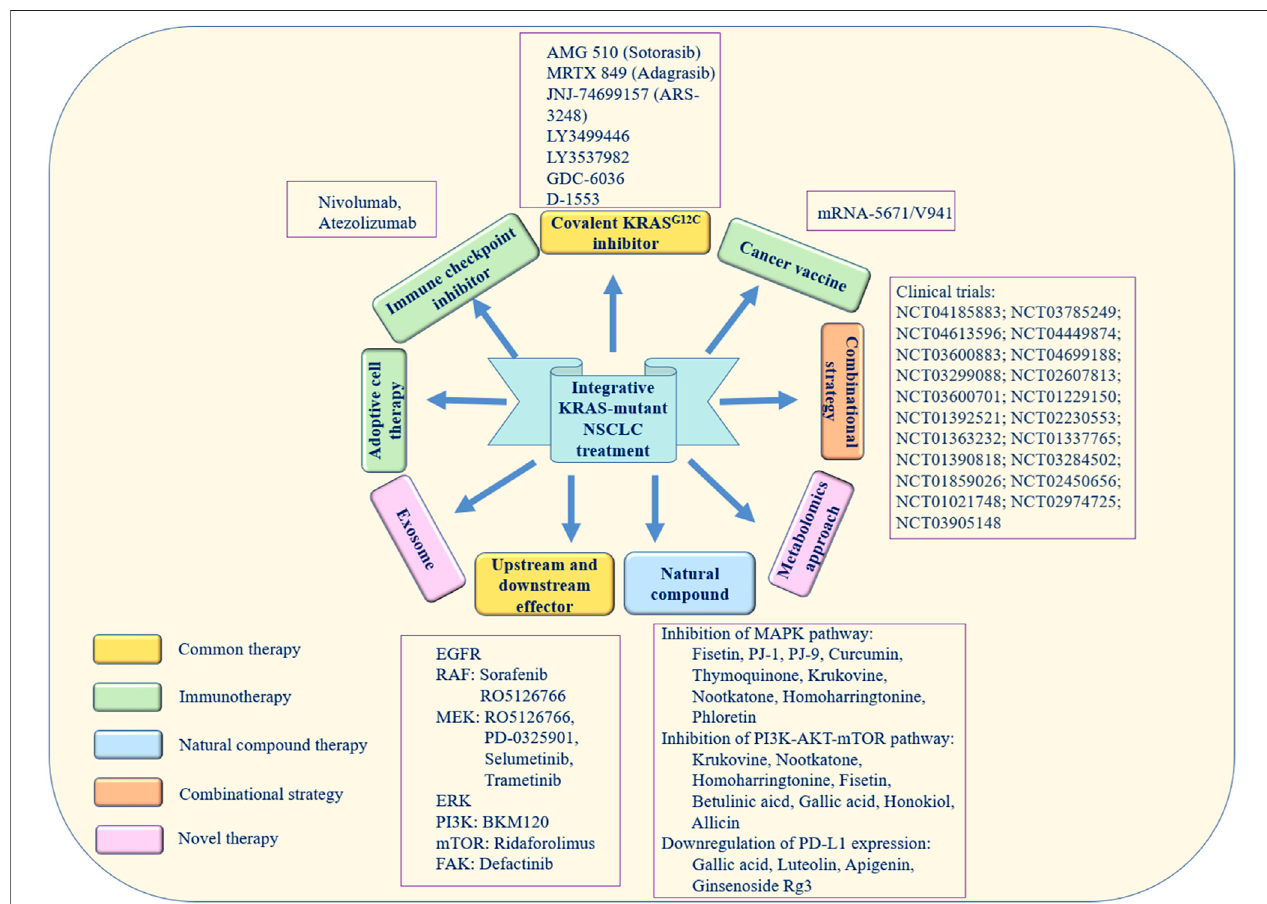
FIGURE3| Integrative therapeuticapproachesforKRAS-mutantNSCLC.Theyellowboxesrepresent directandindirecttreatmentstargetingtheKRASmutation. The green boxes represent immunotherapy. The blue box represents natural compound therapy. The orange box represents combination treatment. The pink boxes represent novel